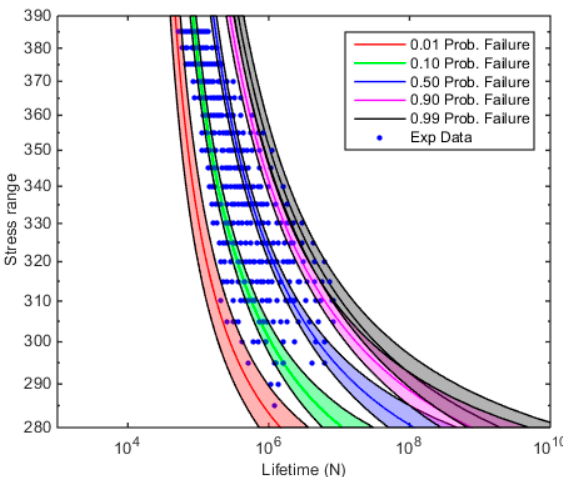
Figure 8. The 0.01, 0.10, 0.50, 0.90, and 0.99 quantile S-N curves and the 0.01–0.99 confidence intervals for the Maennig data.